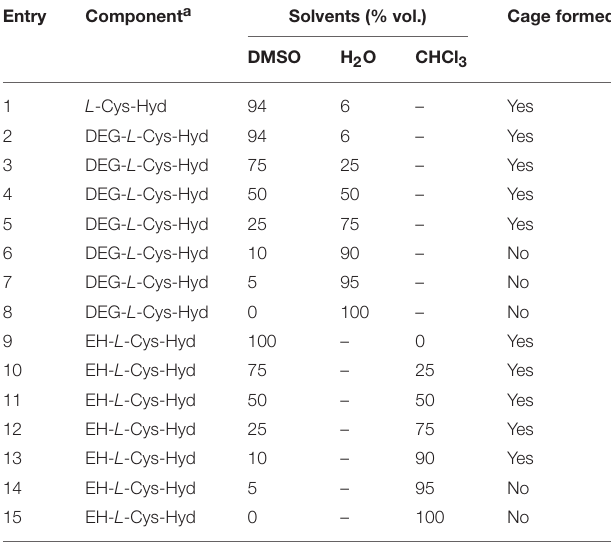
TABLE 1 | Screening of cage formation in different solvent systems using L -Cys-Hyd (8), DEG- L -Cys-Hyd (9), and EH- L -Cys-Hyd